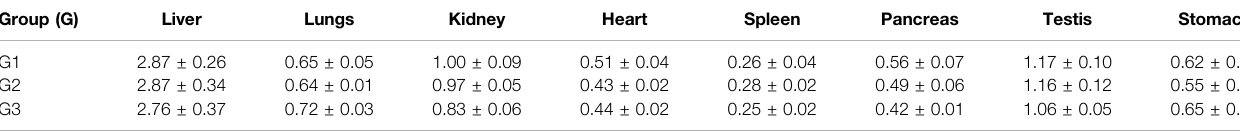
TABLE 1 | Effect of bacteriophages in sub-chronic toxicity assay for the organ to body weight ratio (in percentage). Group (G) Liver Lungs Kidney Heart Spleen